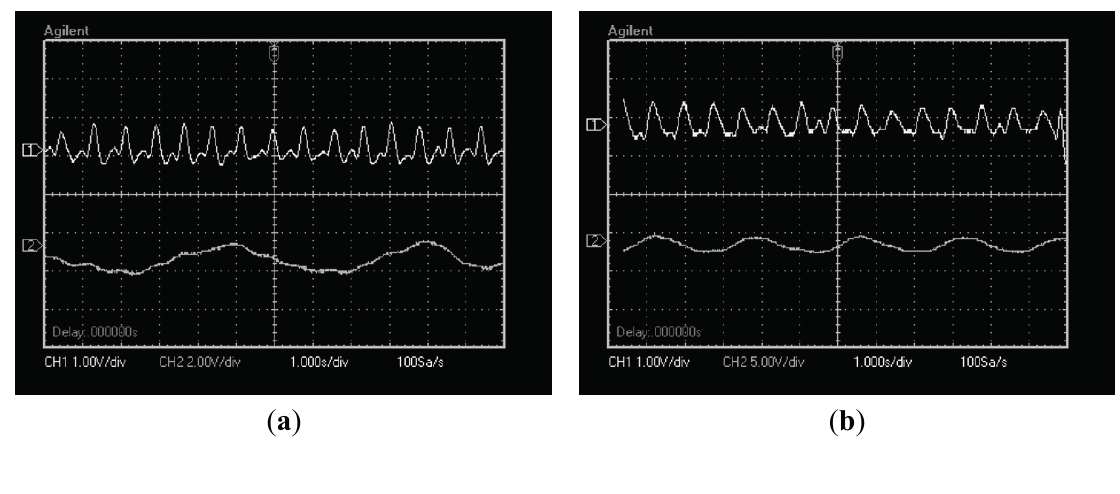
Figure 13. Signals obtained of proposed sensor for 10 subject tests ( a – j